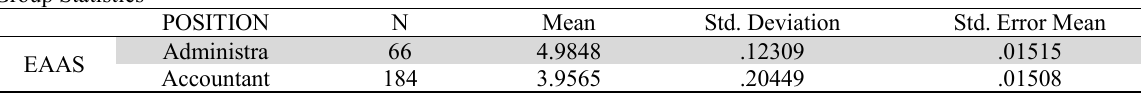
Independent Samples Test Equal variances EAAS